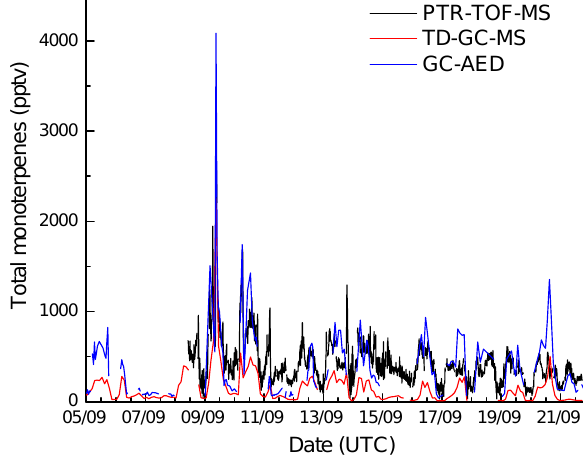
Figure 6. Time series of total monoterpenes from GC-AED (black), GC-MS (red), and PTR-TOF-MS (blue). The data are reproduced as histograms in Fig. S3 of the